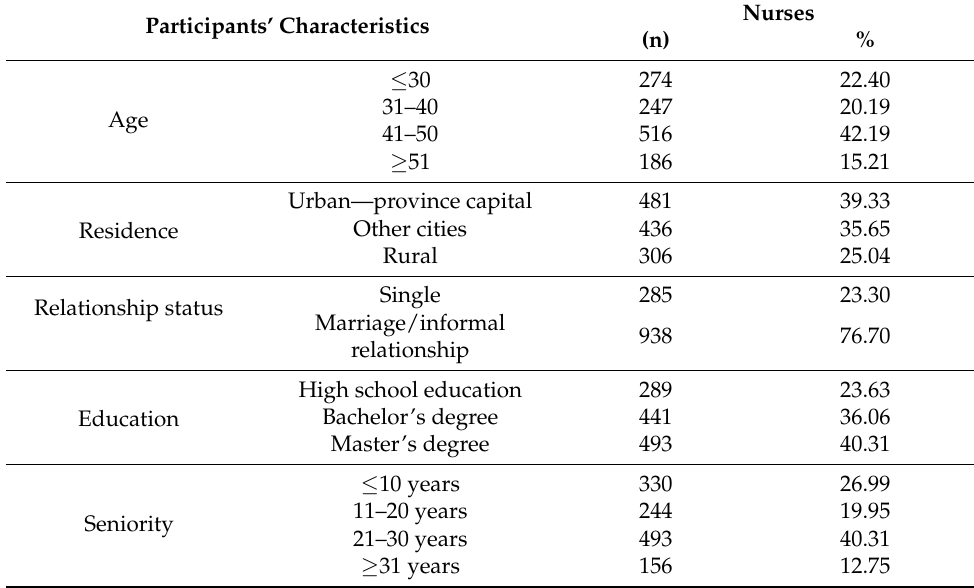
Table 1. Participants’ baseline